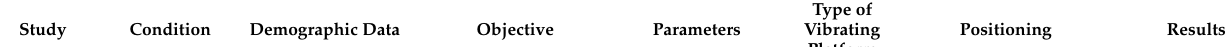
Table 1. Different populations submitted to WBV exercise, with symptoms also observed in the COVID-19 patients: fatigue. Study